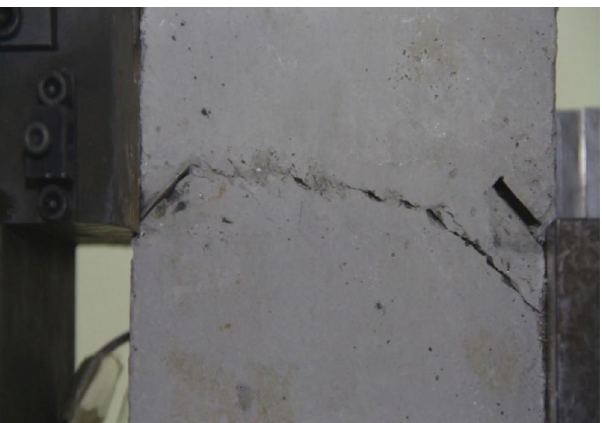
Figure 29. Photograph of a specimen showing fractures propagate in the middle of the rock mass.